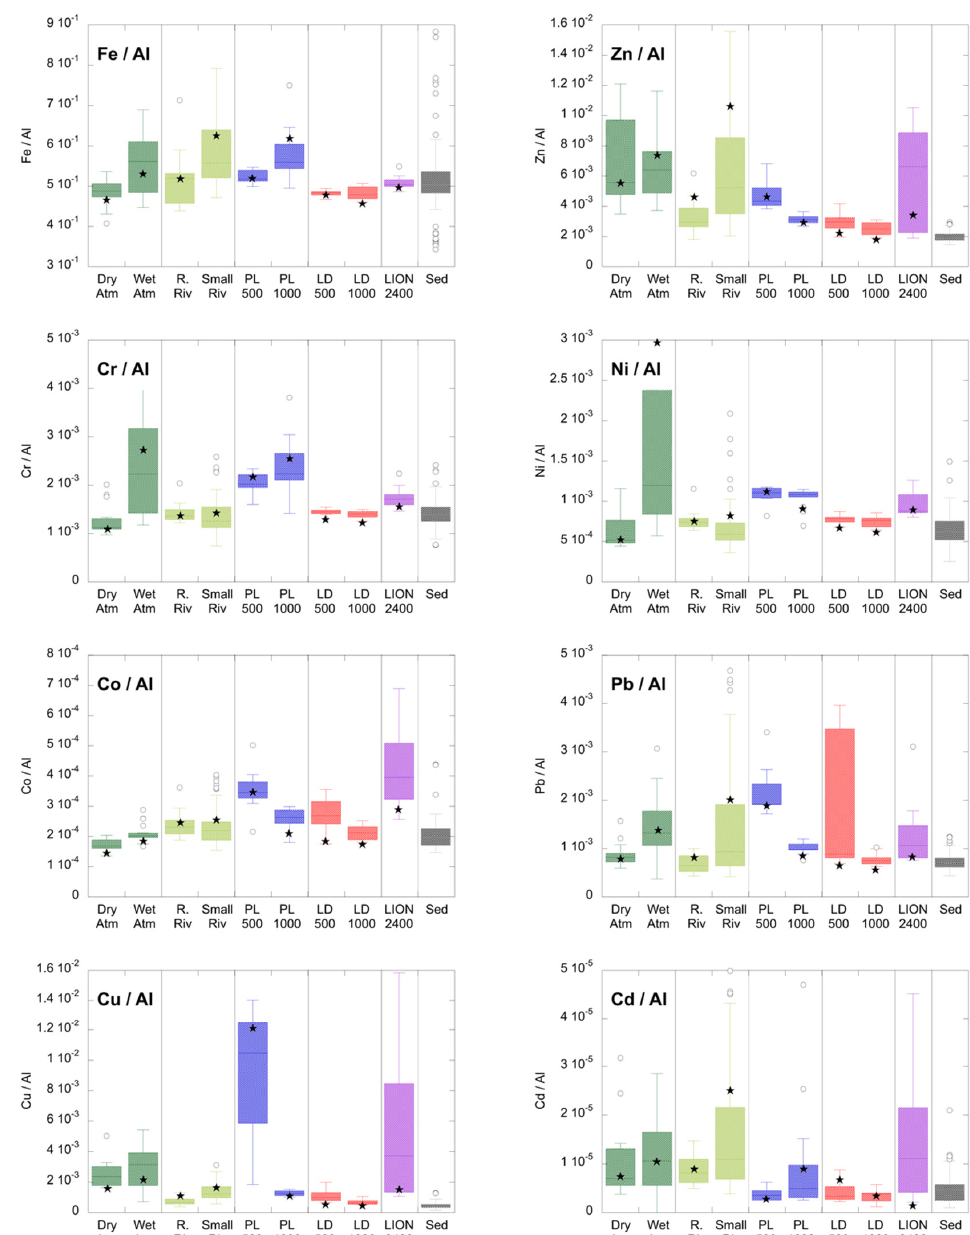
Figure 6. Box and whisker plots of selected Al-normalized metals (Zn, Cr, Ni, Co, Pb, Cu, Cd) for the particulate fluxes collected in dry (Dry Atm) and wet atmospheric (Wet Atm) deposits, in the Rhône River (R. Riv) and the other small rivers (Small Riv), in the Planier (PL) and Lacaze-Duthiers (LD) Canyons at 500 (mid-depth) and 1000 m (near-bottom), in the basin (LION) at 2400 m (near-bottom) as well as for the superficial sediments (Sed) measured for the year 2012. Average concentration for the cascading and convection events in February–March 2012 are indicated by black stars ( ★ ). See Figure 1 for the location of the sampled stations. Each box of the box and whisker plots encloses 50% (between the lower and upper quartiles) of the data with the median value of the variable displayed as a line. The length of the whiskers is restricted to a maximum of 1.5 times the interquartile range. Any value outside of this interval are represented as points and considered as potential outliers.